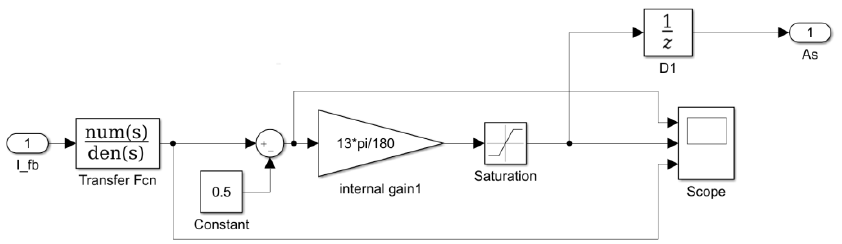
Figure 4. Internal view of the advance angle adjustment.